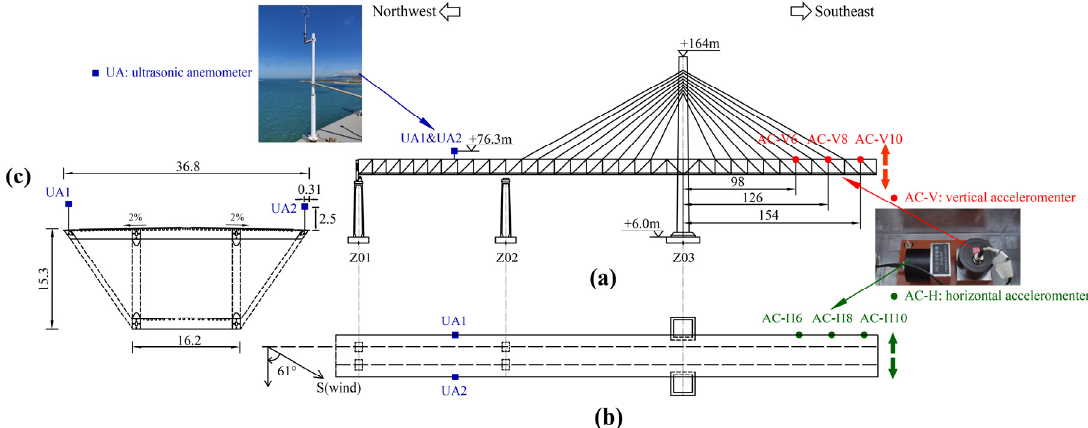
Figure 3. Arrangement of measurement sensors at the bridge under extreme single-cantilever state: ( a ) Elevation view; ( b ) Plan view; ( c ) Cross section of the bridge girder.